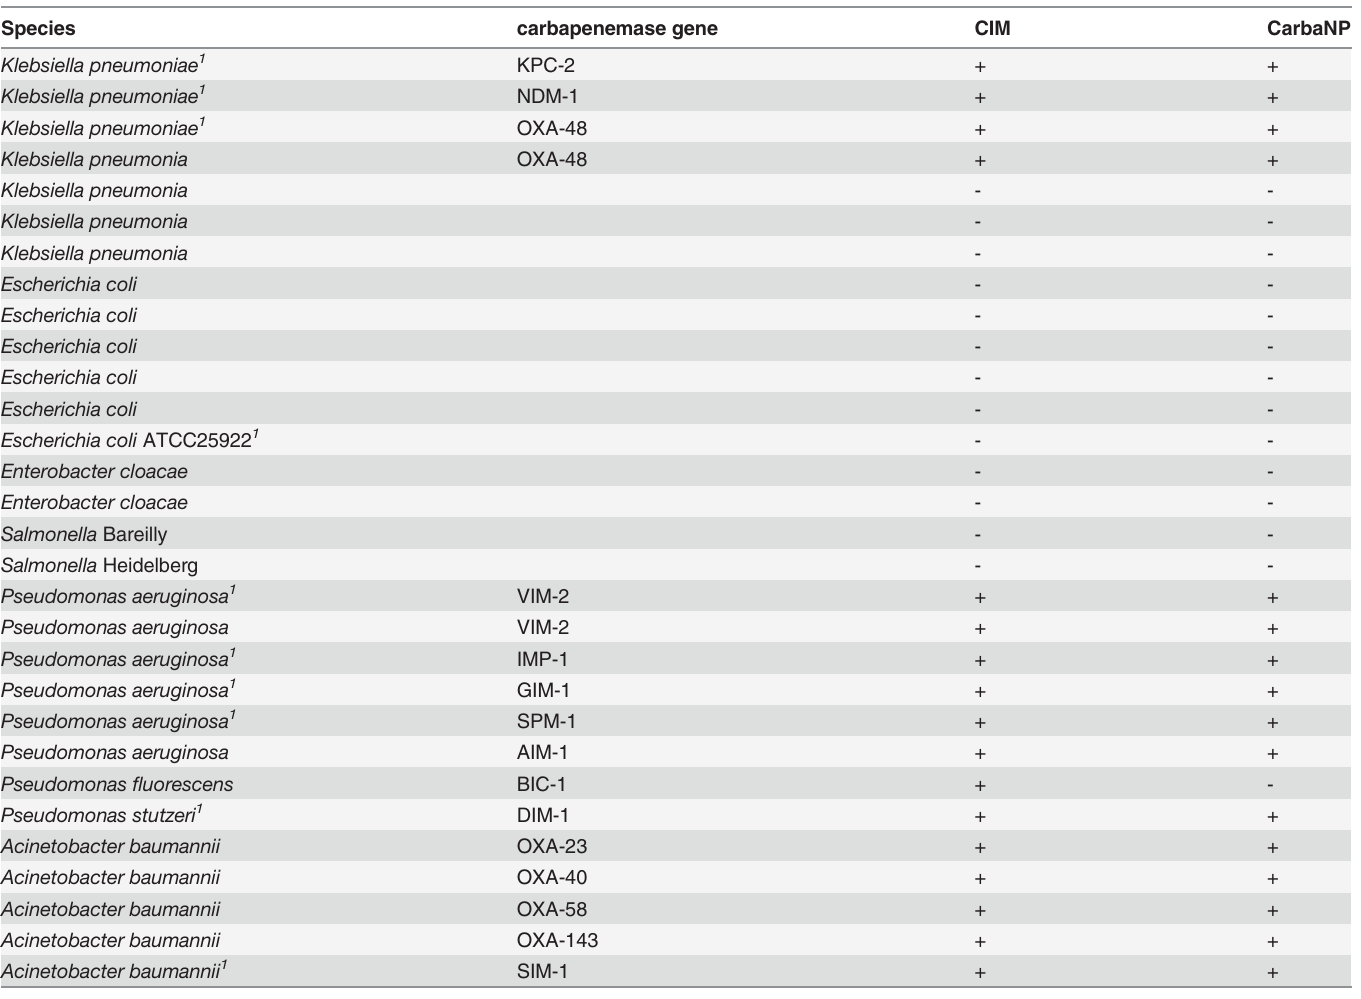
Table 1. Isolates used for validation of the